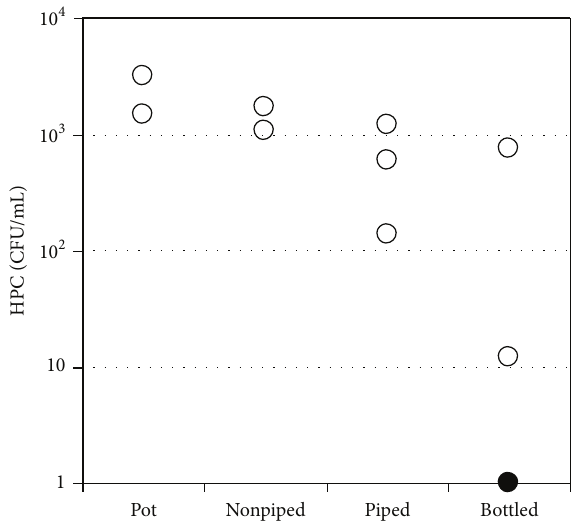
Figure 5: Heterotrophic plate count for potable water.